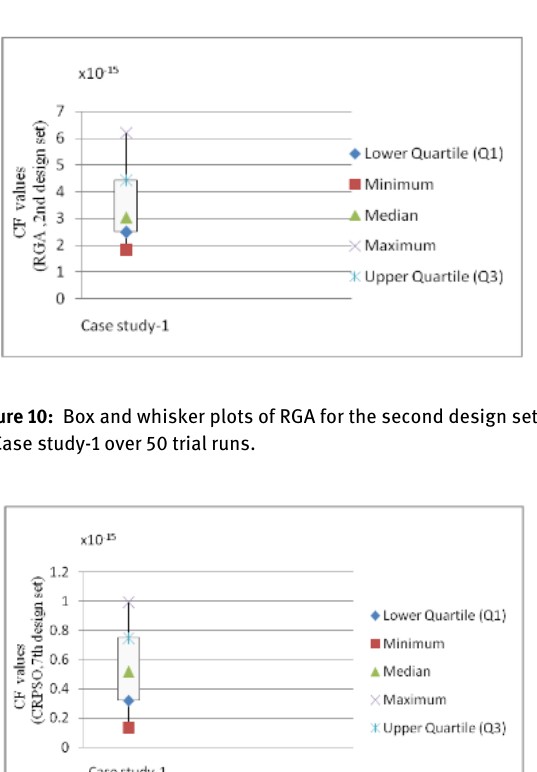
Figure 11: Box and whisker plots of CRPSO for the seventh design set of Case study-1 over 50 trial